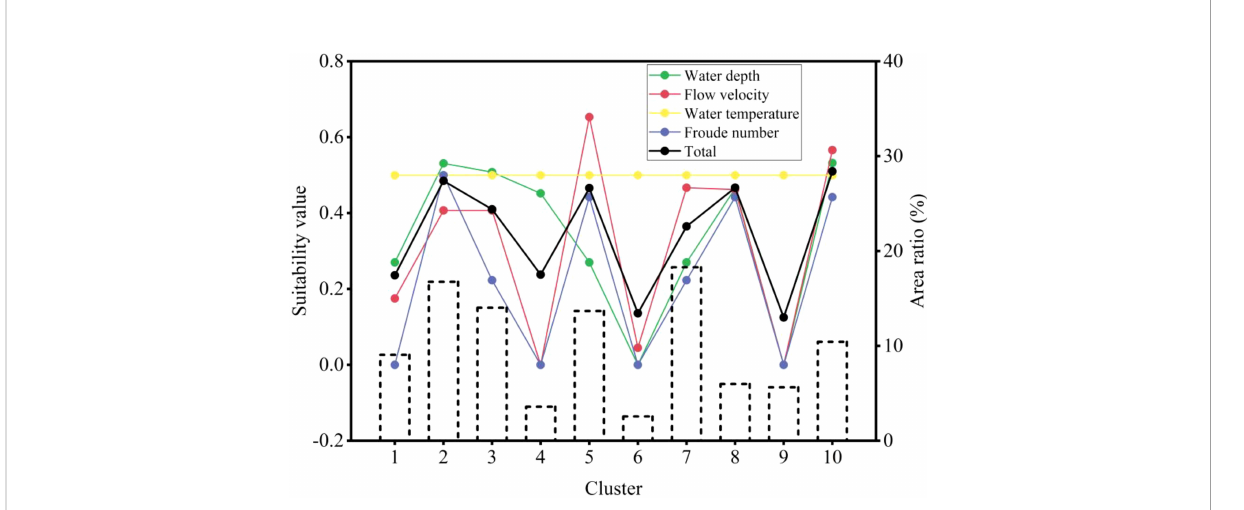
FIGURE 10 Suitability values and Area ratio of each cluster. The line chart uses the left ordinate. The histogram uses the ordinate on the right. The line chart shows the suitability values of water depth, fl ow velocity, water temperature, Froude number, and total for ten clusters of spawning grounds. The histogram represents the area proportion (%) of ten clusters.